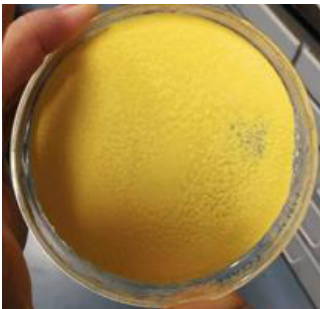
Figure 2. Magnesium iron oxalate precipitate obtained after filtration by oxalate coprecipitation method.